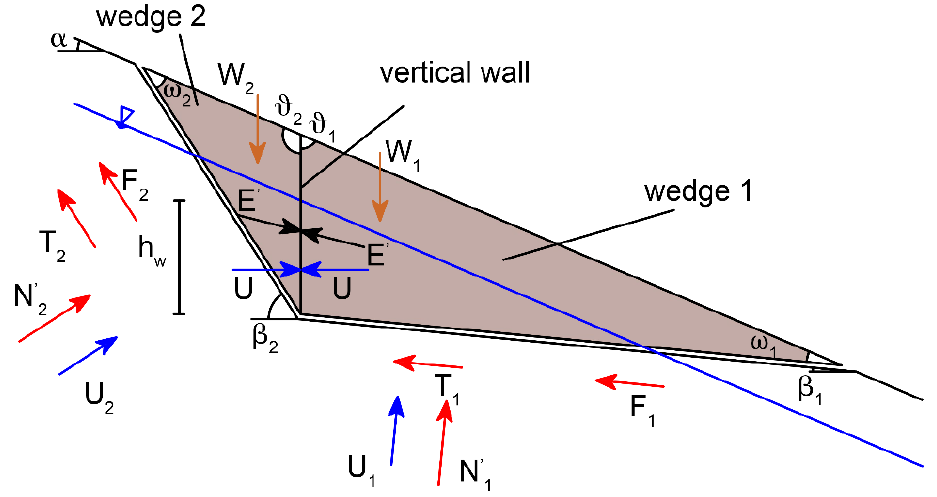
Figure 2. Forces acting on the wedges.